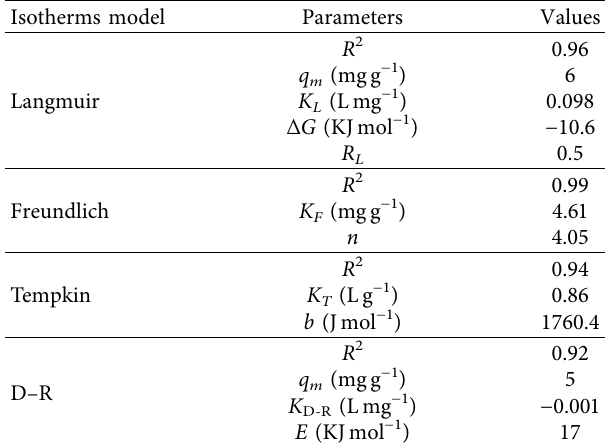
Figure 15: Temkin (a) and D–R (b) isotherm modeling of fluoride adsorption onto GO. Table 4: The four isotherm models’ parameter values for fluoride adsorption by